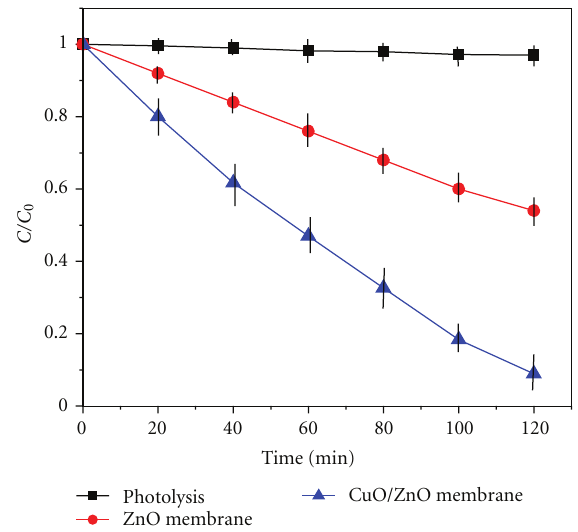
Figure 9: The concentration change of RhB under the irradiation of visible light on the CuO/ZnO membrane and ZnO membrane.